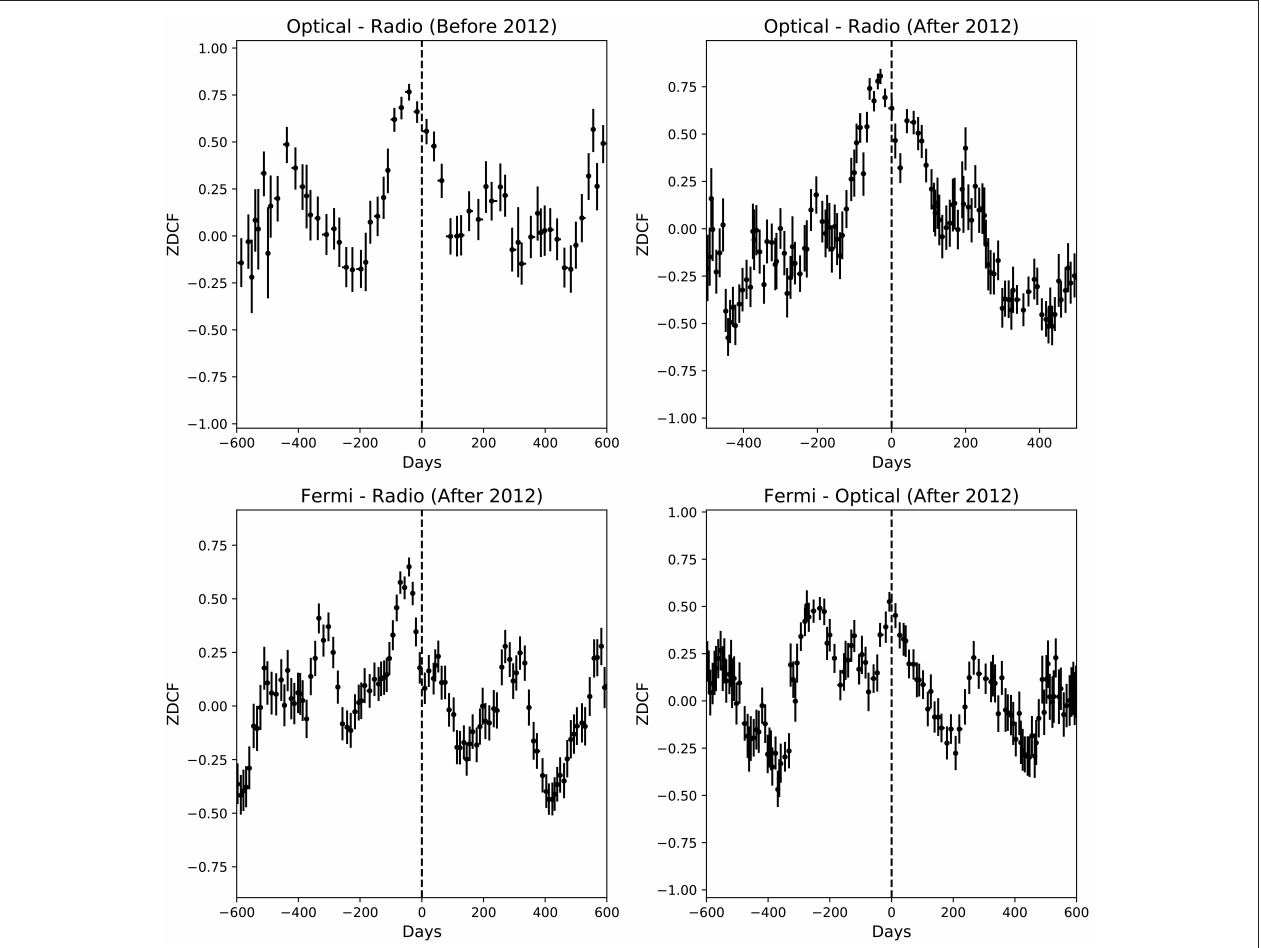
FIGURE 2 | The significant correlation functions between all light curves. (Top left) Optical-Radio before 2012; (Top right) Optical-Radio after 2012; (Bottom left) Fermi-Radio after 2012; (Bottom right) Fermi-optical after 2012. A negative lag indicates that the lower energy band comes after.